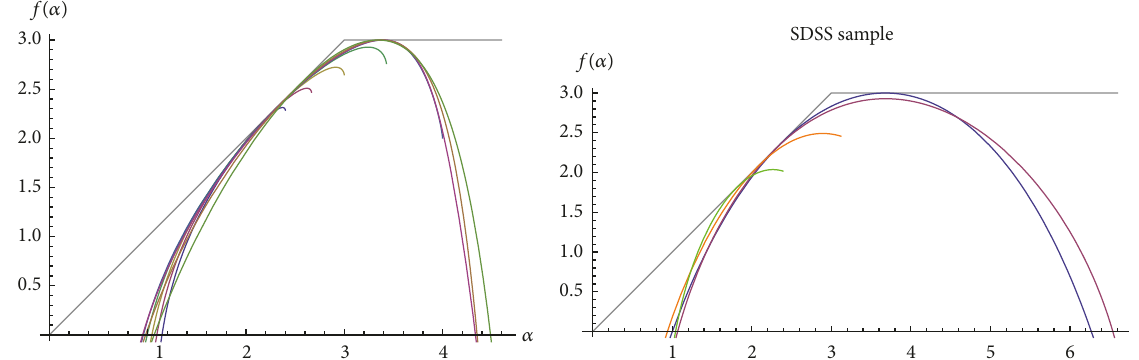
Figure 5: The multifractal spectra of the dark matter distribution in the Bolshoi simulation (coarse-graining lengths 𝑙 = 3.91, 1.95, 0.98, 0.49, 0.24, 0.122, 0.061, 0.031 Mpc /ℎ ) and of the stellar mass in a volume-limited galaxy sampleof the Sloan Digital Sky Survey (coarse-graining lengths 𝑙 = 11.5, 5.76, 2.88, 1.44 Mpc /ℎ